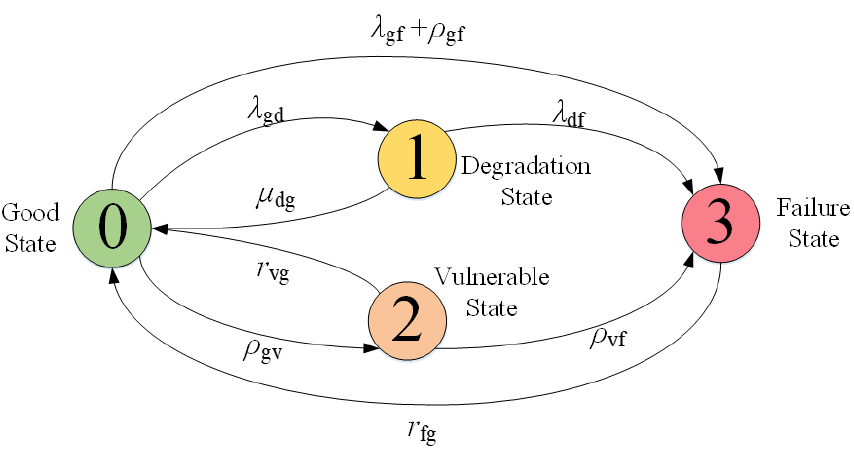
Figure 3. CTMC model of a single RAID disk subject to faults and